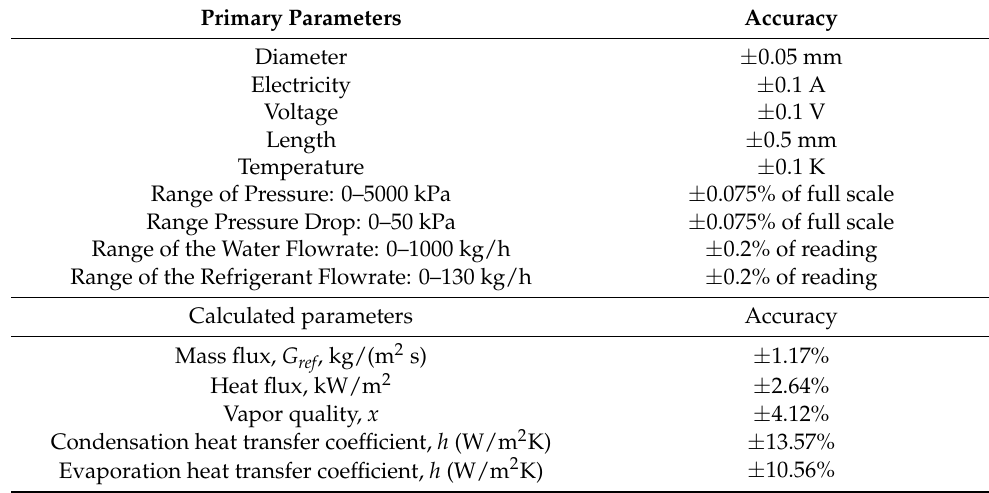
Table 2. Accuracy of the various primary and calculated